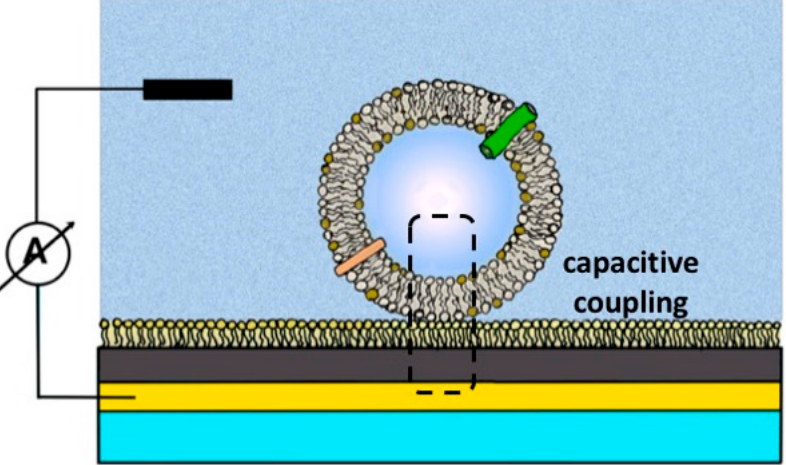
Figure 3. Schematic representation of the system for electrophysiological measurements on solid- supported membranes. SSM comprises a glass slide (light blue) covered by a very thin gold layer (in yellow) that binds thiol groups (in grey) of an alcanethiol reagent. A lipid monolayer completes the system. Proteoliposomes or native membrane vesicles as well as membrane fragments are adsorbed to the lipid monolayer. A change in the charge across the proteoliposome due to the activation of ion channels or transporters induces a correspondent change in the charge across the SSM, which is supplied by the amplifier (A). Therefore, as indicated by the box, a capacitive electrical coupling is established. The transient currents due to this coupling provide information on the properties of the channels/transporters (in green and orange) present in the adsorbed means (for a detailed and exhaustive description, see [68].